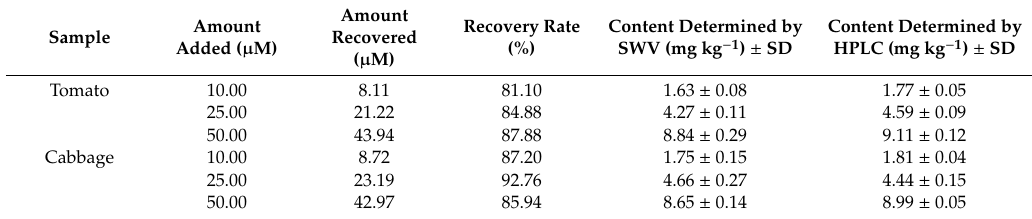
Table 2. Determination results for CBL in real samples.